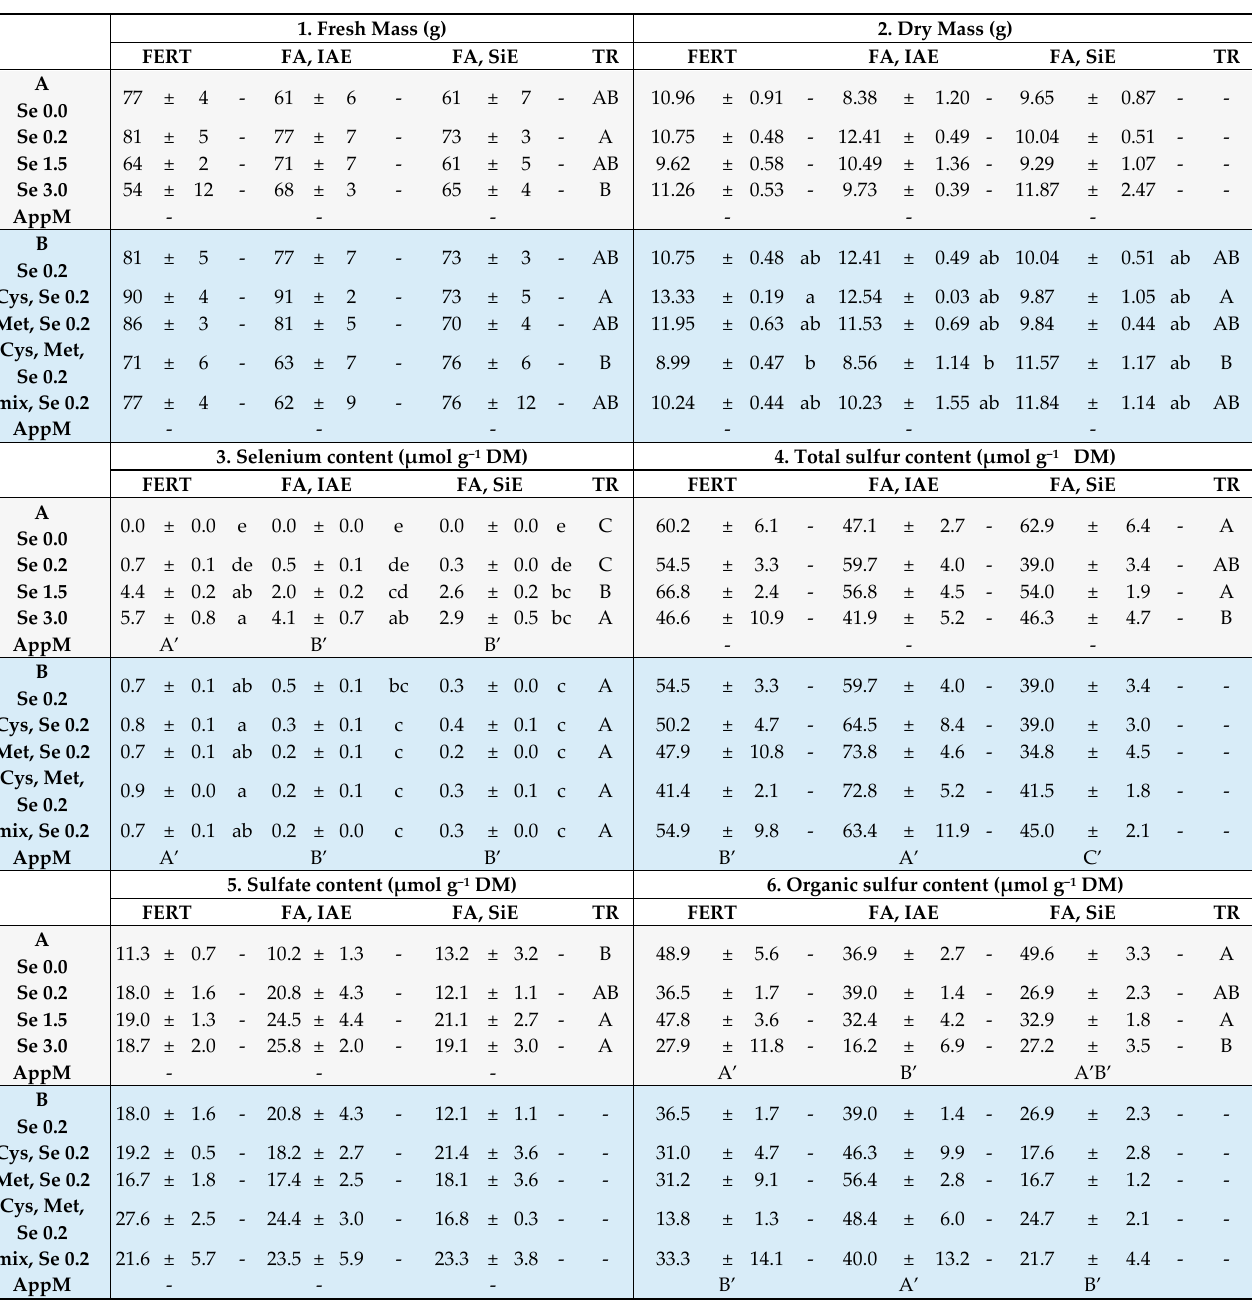
The applications that reduced the FM were Se1.5/FERT ( − 17%) and Se3.0/FERT ( − 30%), Table 1. The performance of the increased selenium concentration (A) or the combination of selenium 0.2 mM with amino acids (B) and application mode on the biofortification of florets. Means +/ − SE are provided for (1) fresh mass, (2) dry mass, along with (3) selenium, (4) organic sulfur, (5) sulfate, and (6) total sulfur contents. Different letters indicate statistically significant differences in Tukey–Kramer test at p ≤ 0.05. TR : statistical evaluation among the application modes. AppM : statistical evaluation among the treatments. Dash indicates that the two-way ANOVA did not reveal any differences at the p < 0.05 level. In the A group, control treatment served the fertigation without Se application (Se0.0/FERT). In the B group, control treatment served the fertigation with Se 0.2 mM (Se0.2/FERT).